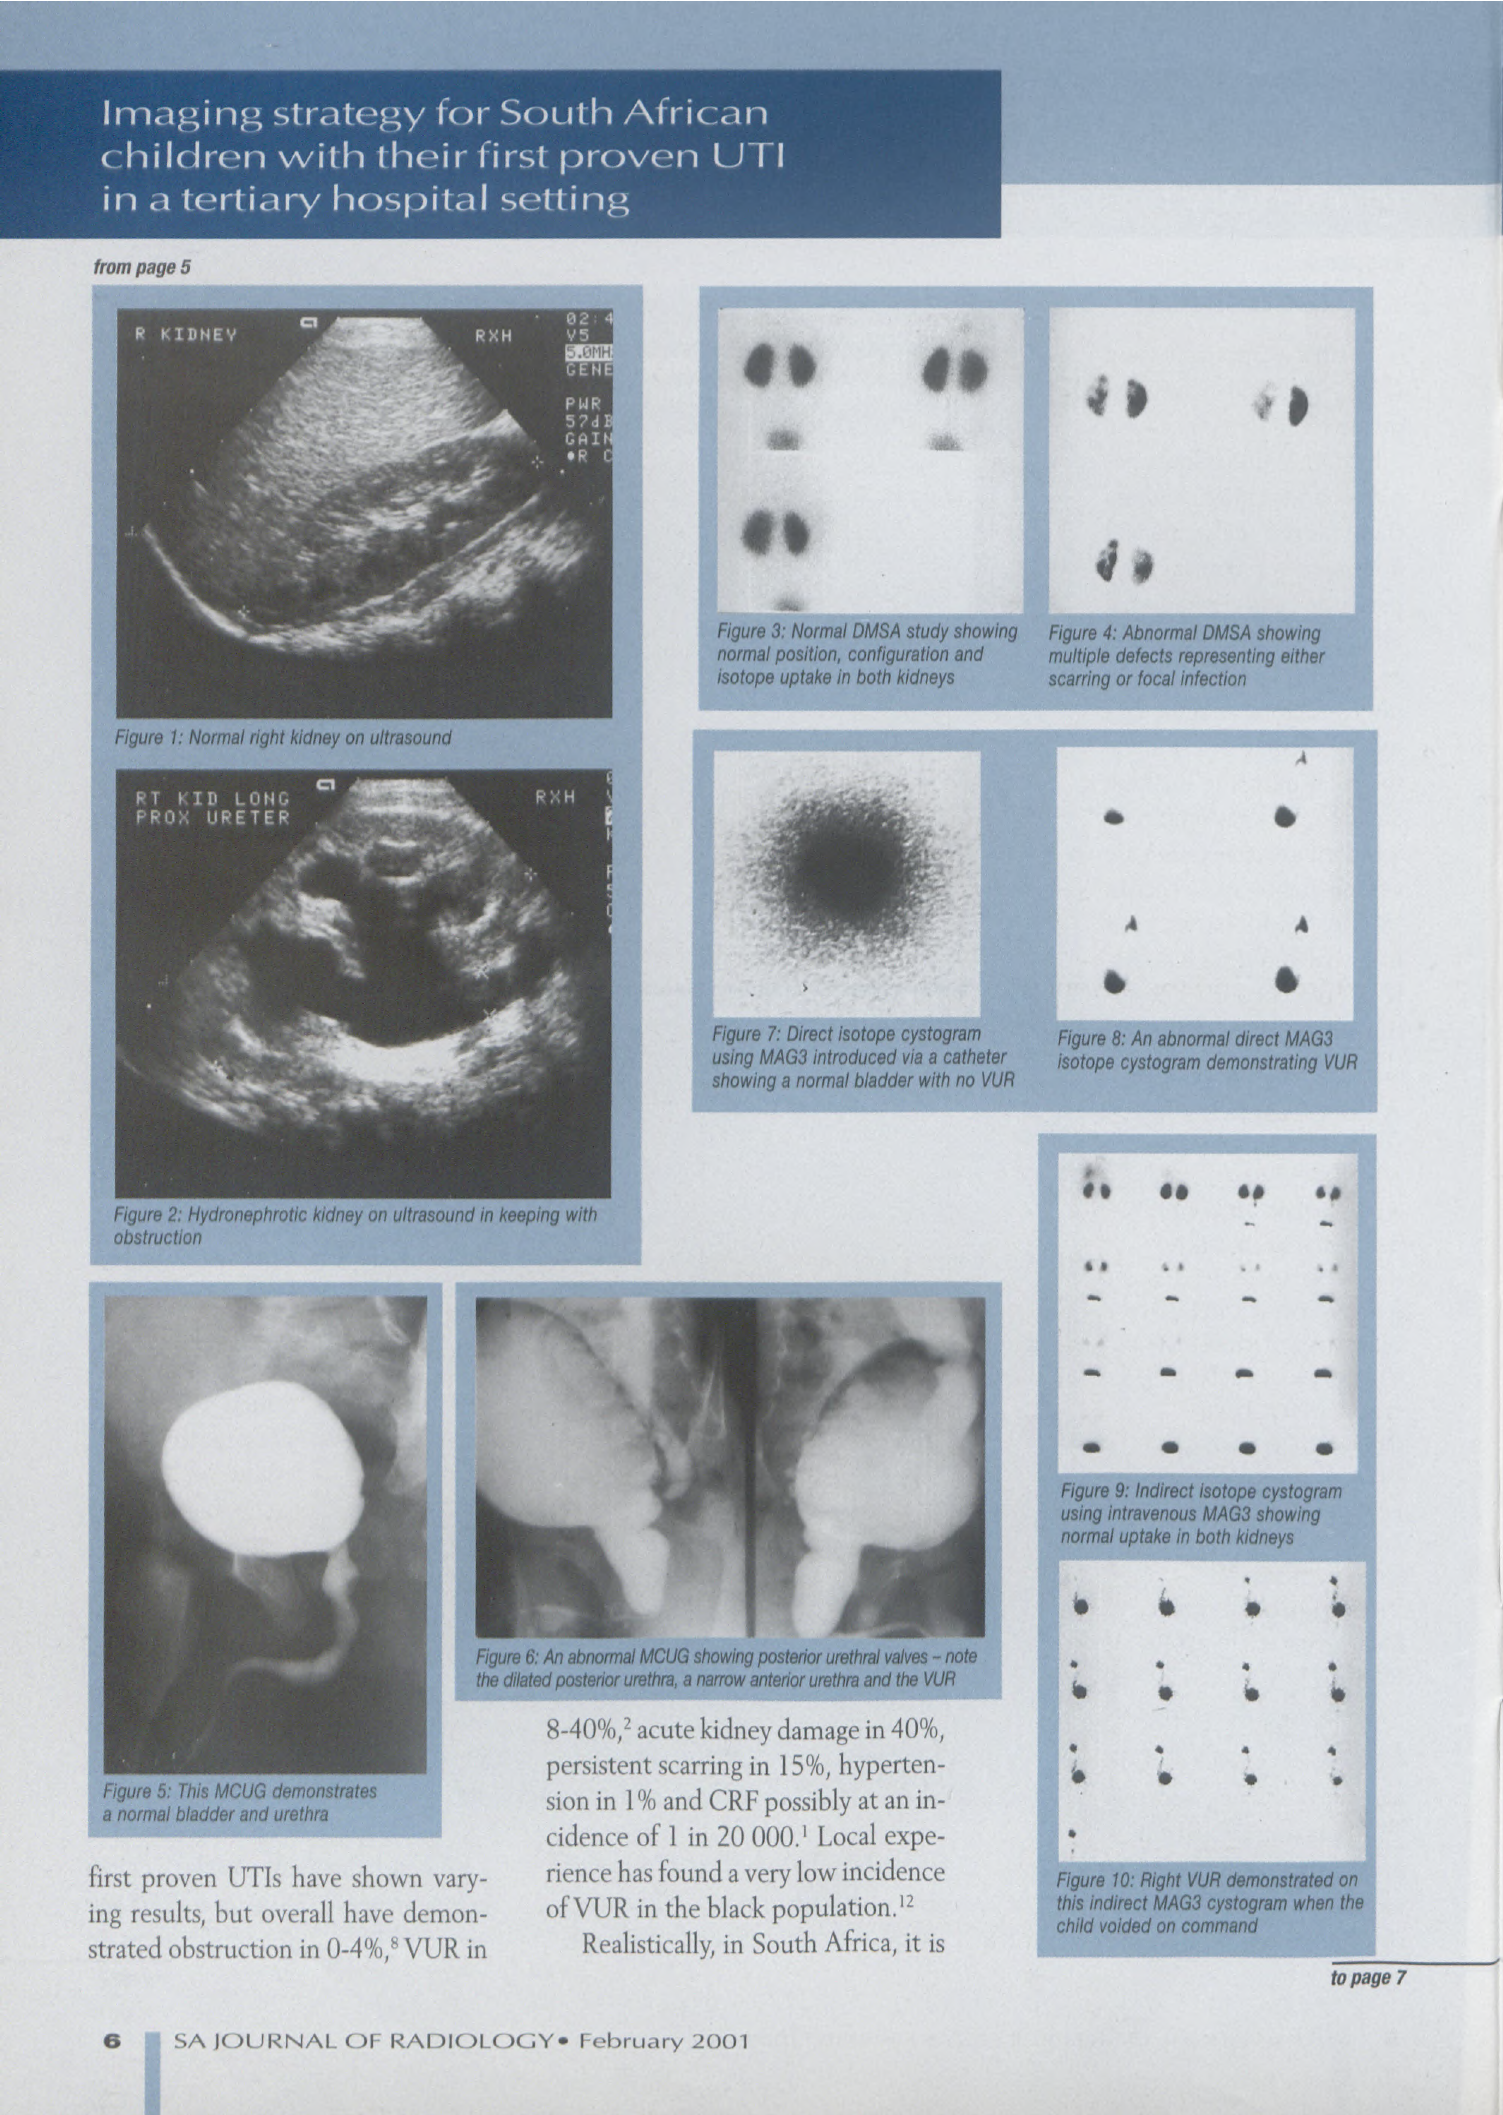
Figure 6: An abnormal MCUG showing posterior urethral valves- note the dilated posterior urethra, a narrow anterior urethra and the VUR 8-40%,2 acute kidney damage in 40%, persistent scarring in 15%, hyperten- Figure 5: This MCUG demonstrates sion in 1% and eRF possibly at an in- a normal bladder and urethra cidence of 1 in 20 000. J Local expe- rience has found a very low incidence ofVUR in the black population.F Realistically, in South Africa, it